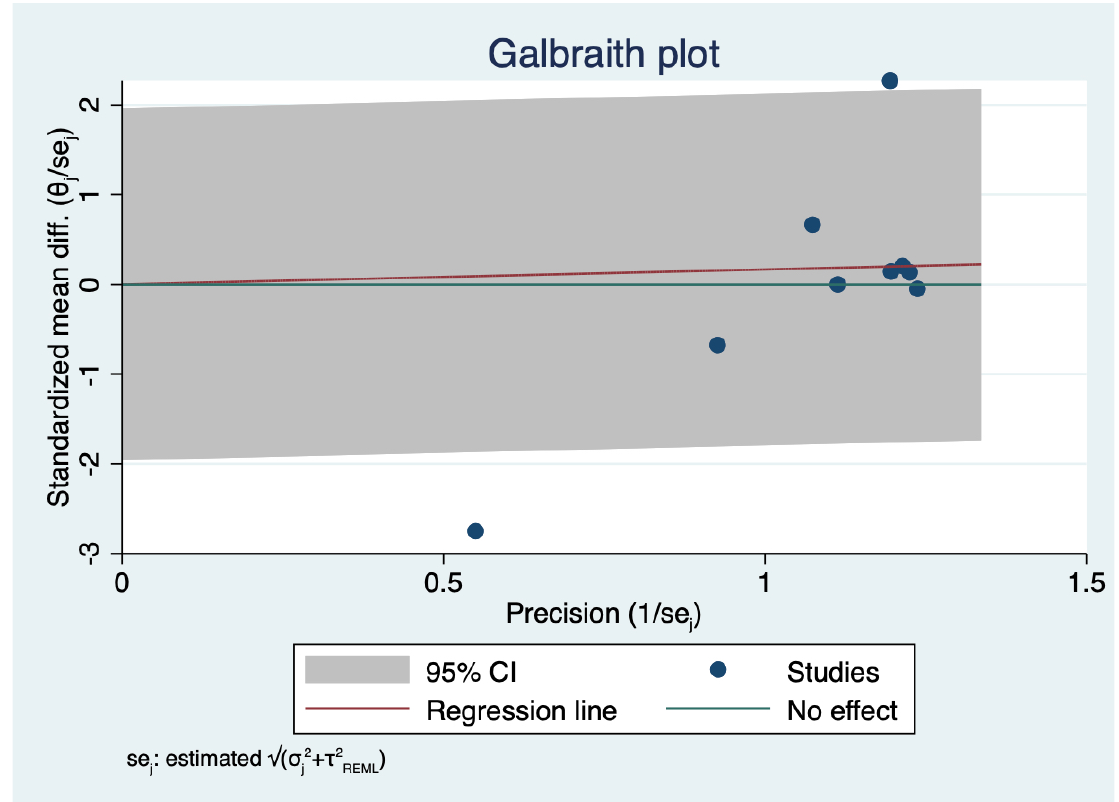
Figure 3. Analysis of heterogeneity across studies: Galbraith plot of mean surgical duration time: The red line depicted the regression line, parallel to the regression line, at a 2-standard-deviation distance, 2 lines (dotted green lines) created an interval in which seven studies (in small circles) fell, indicating 2 potential